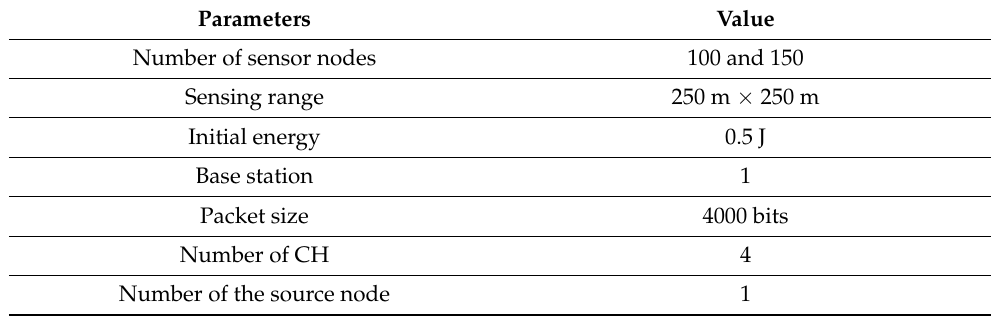
Table 1. Simulation